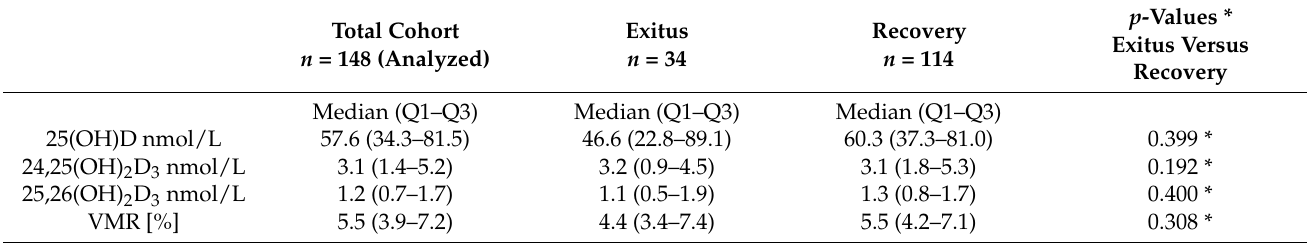
Figure 1. Difference of 25(OH)D (nmol/L) between the pulmonic treatment groups ( p = 0.723, Kruskal–Wallis test). The median serum concentration of 25(OH)D was 57.6 nmol/L. Sixty-one individuals had low 25(OH)D concentrations of less than 50 nmol/L. Table 2 provides the descriptive statistics of all measured vitamin D metabolites and the VMR. 24,25(OH) 2 D 3 , the principal catabolite of 25(OH)D 3 accounted for 5.5% of the total 25(OH)D concentration. The second with the two vitamin D catabolites 24,25(OH) 2 D 3 ( r = 0.884, p < 0.001) and 25,26(OH) 2 D 3 ( r = 0.932, p < 0.001). Table 2. Vitamin D metabolite concentrations of hospitalized Sars-Cov-2 patients measured in the first routinely collected serum sample after